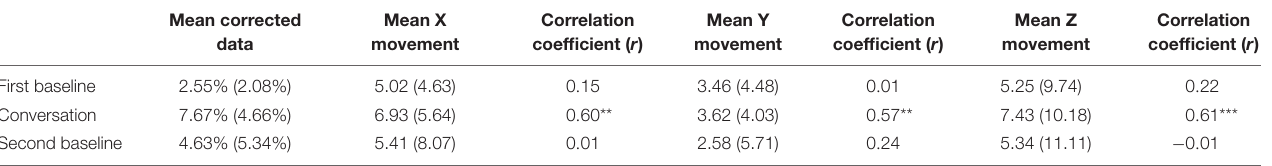
TABLE 5 | Mean (standard deviation) corrected data by the external software, mean movement on the X , Y , and Z axes and the correlation between them.